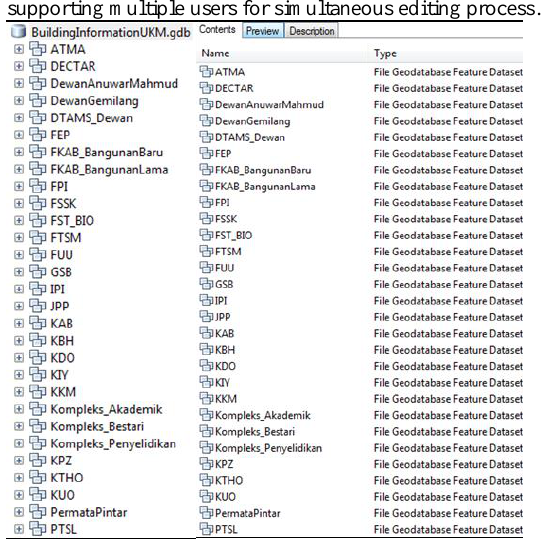
Figure 14. UKM FM building geodatabase (file geodatabase)